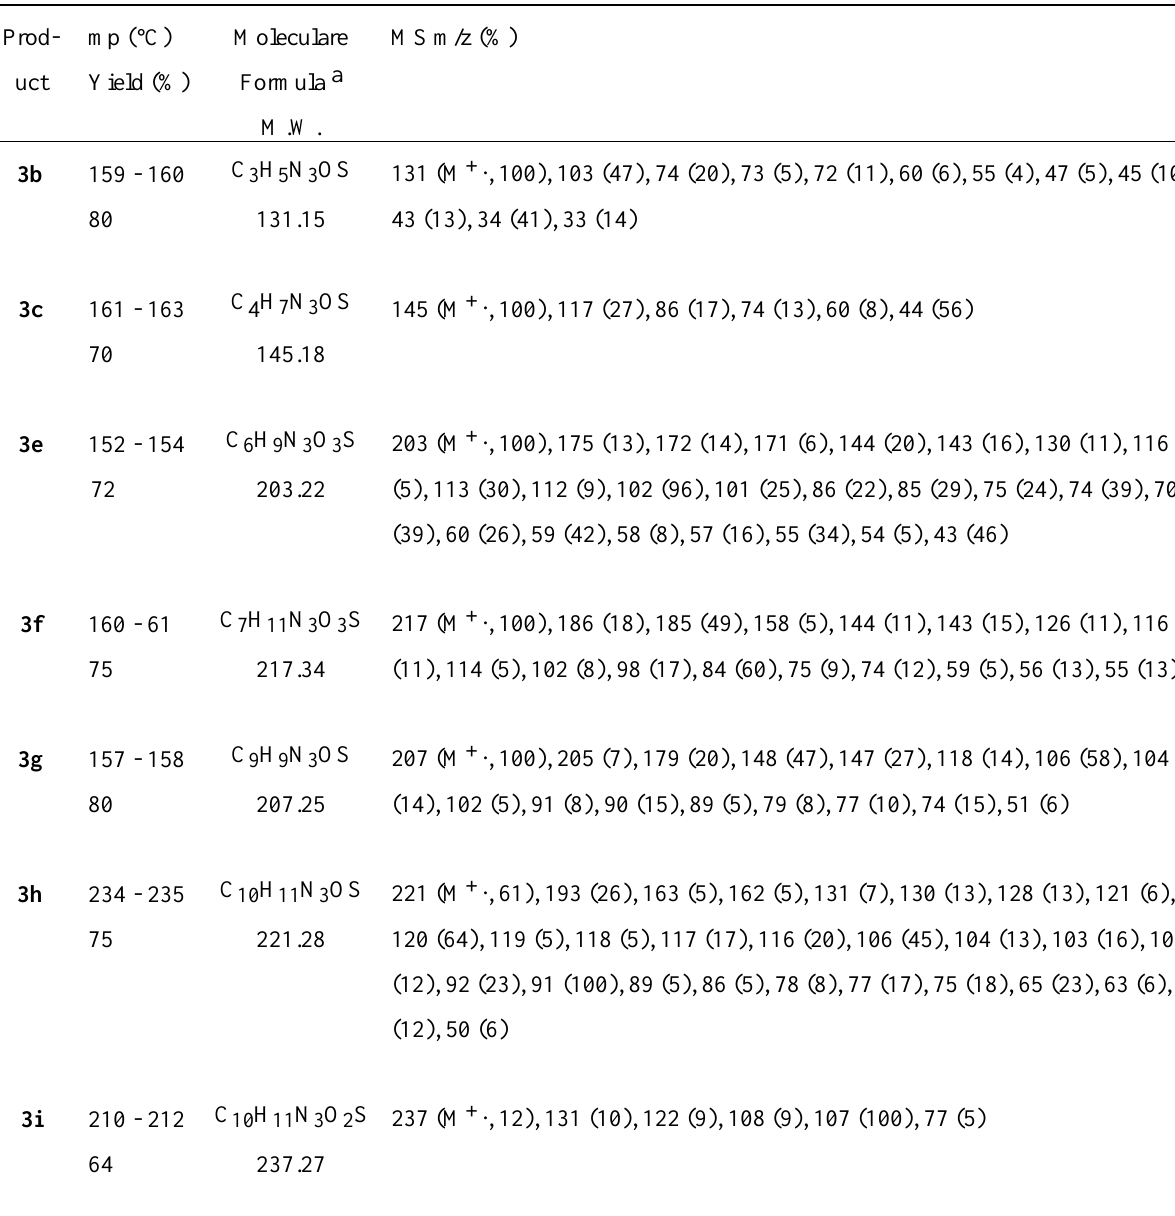
Table 3. Physicochemical data and Mass spectra of 3-Aminothiohydantoins 3 . Prod- mp (°C) Moleculare Yield (%) uct Formula a